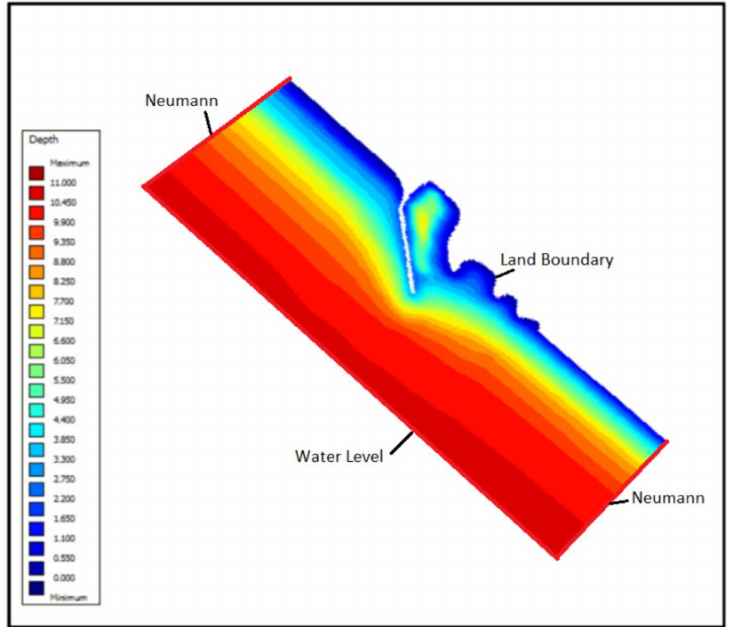
Figure 9. Model domain and boundary